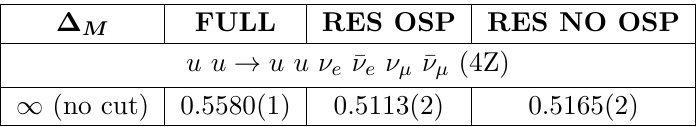
> 20 GeV ; (cid:17) j < t j j